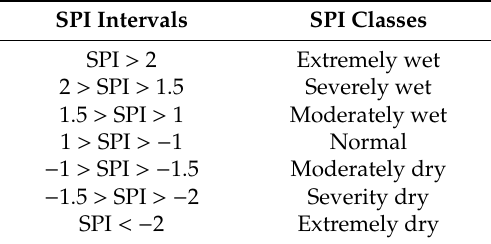
Table 2. Classification of the standardized precipitation index